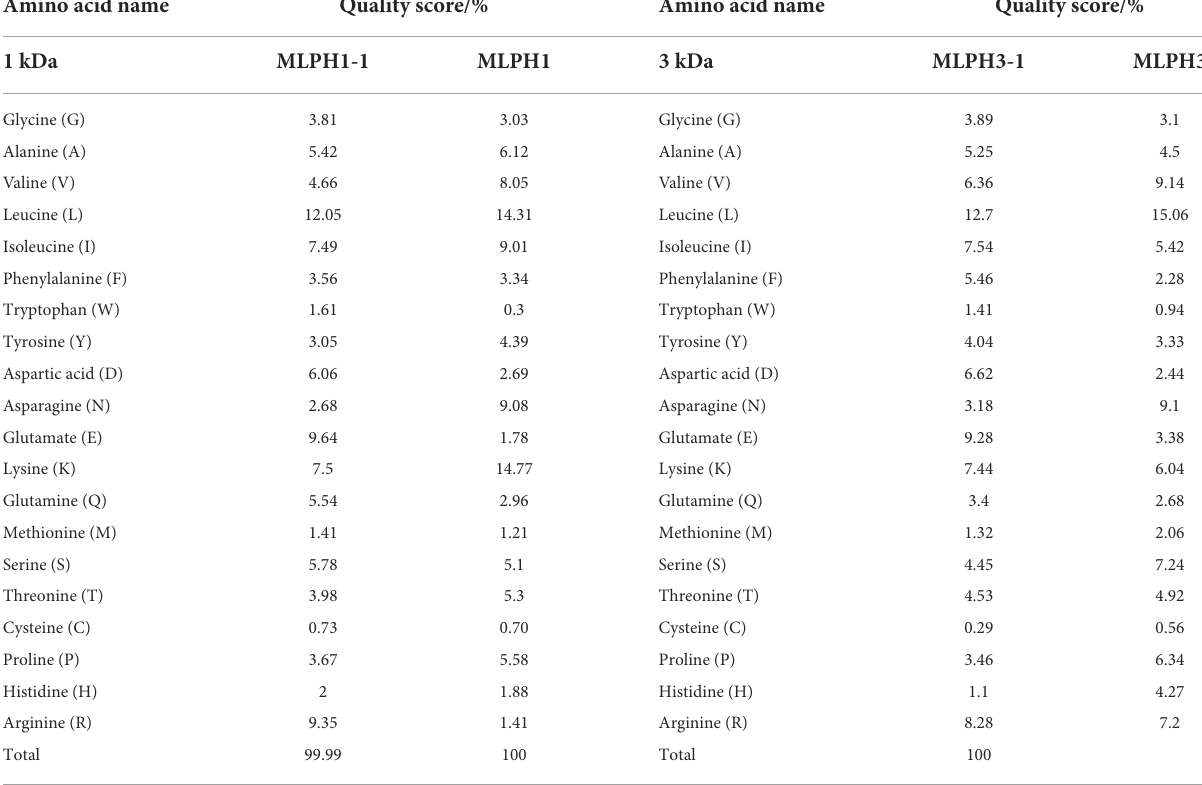
TABLE 1 Amino acid composition of different molecular weight MO leaves proteolytic